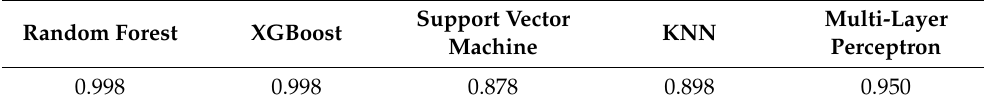
Table 2. Summary of F1_score measures for the models. Random